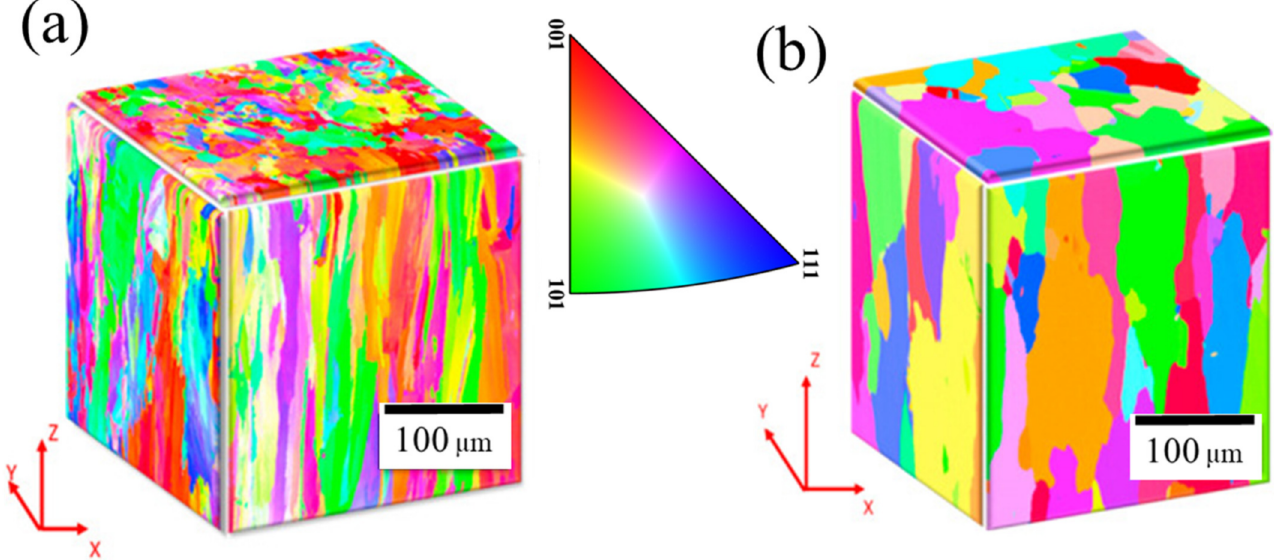
Figure 6. Electron backscatter diffraction of IN713LC fabricated using laser melting in ( a ) as built and ( b ) heat-treated at a temperature of 1175 ◦ C for 2 h conditions. Reprinted with permission from ref. [147]. Copyright 2021